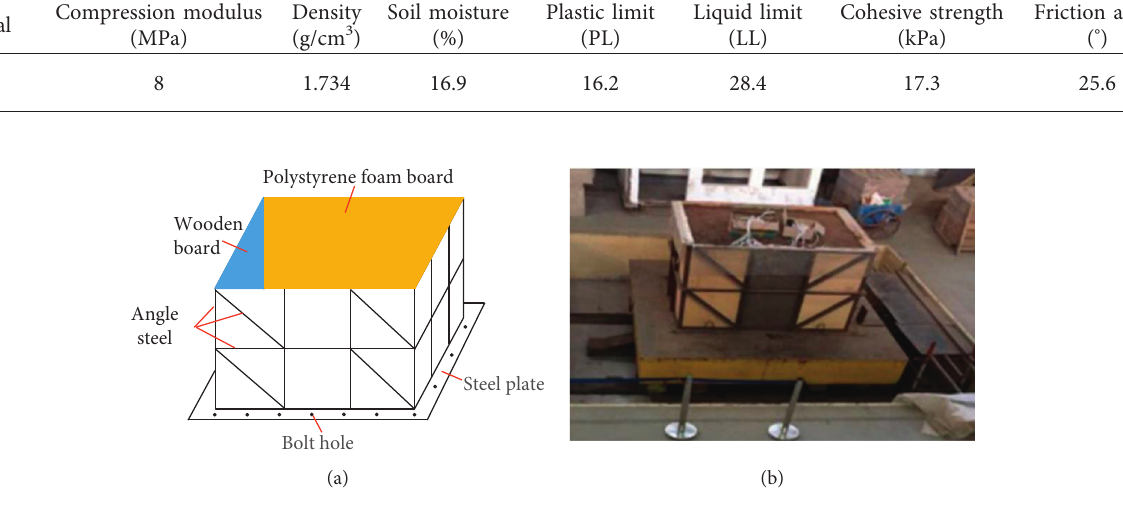
Figure 3: The model container. (a) Design of the model container. (b) The model